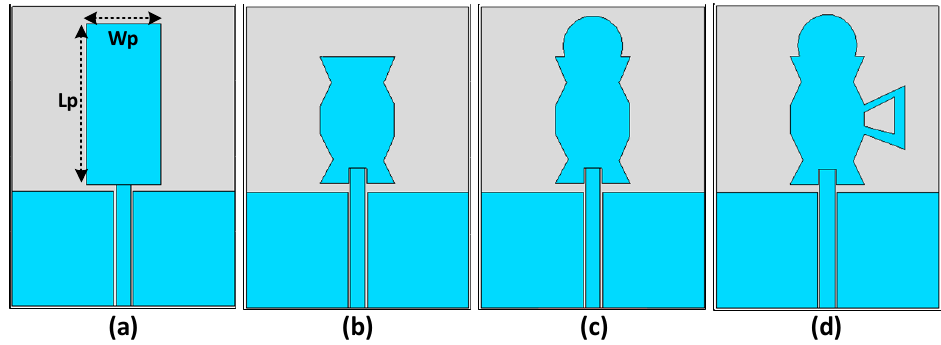
Figure 2. Design steps of the presented ultra-wideband antenna: ( a ) rectangular printed monopole only (ANT I), ( b ) truncated monopole (ANT II), ( c ) addition of semicircular printed monopole (ANT III), ( d ) presented design (ANT IV).